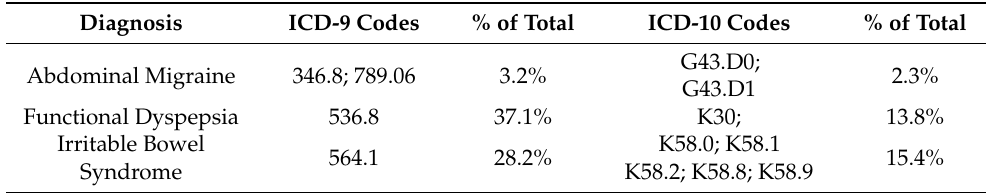
Table 1. Diagnostic codes utilized to identify various abdominal pain-associated functional gastroin- testinal